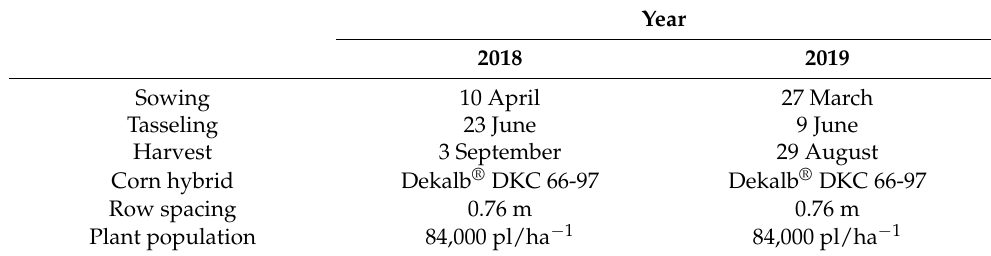
Figure 1. Study field in Lawrence County, Alabama, US.